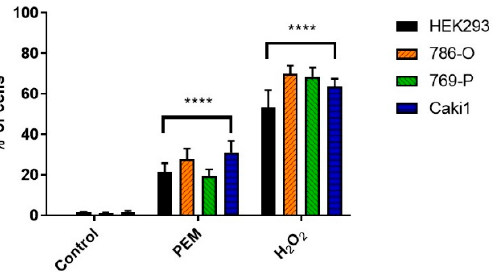
Figure 3. The results of the cytometric analysis of the% cells that produced reactive oxygen species under the influence of 4.5 mT, 50 Hz ELF-EMF. Data presented as mean ± standard deviation: **** p < 0.0001.